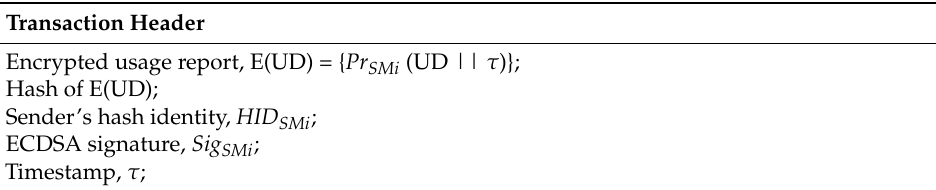
Table 2. Transaction format of smart meter’s electricity usage